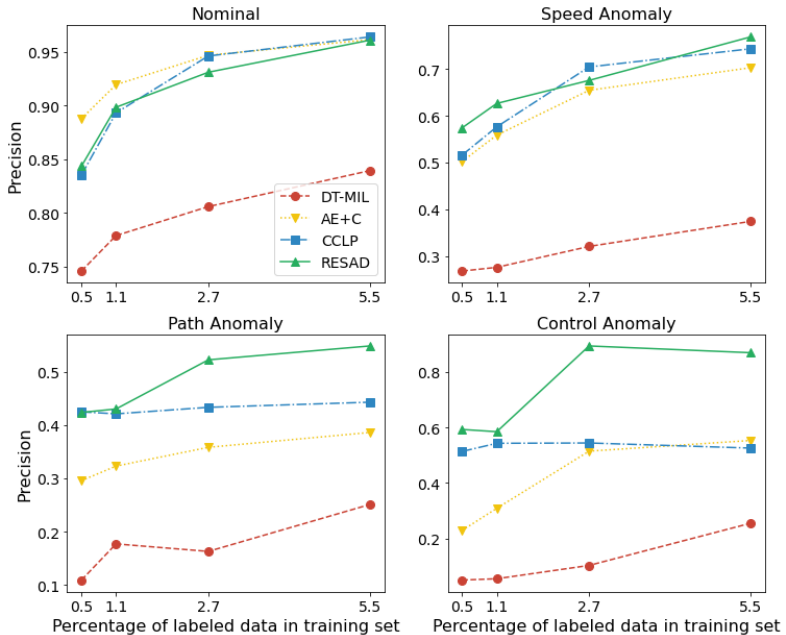
Figure A5. This figure compares performance (precision per class) of our proposed model (colored green) with multiple baseline methods, such as DT-MIL (red), AE+C (yellow), and CCLP